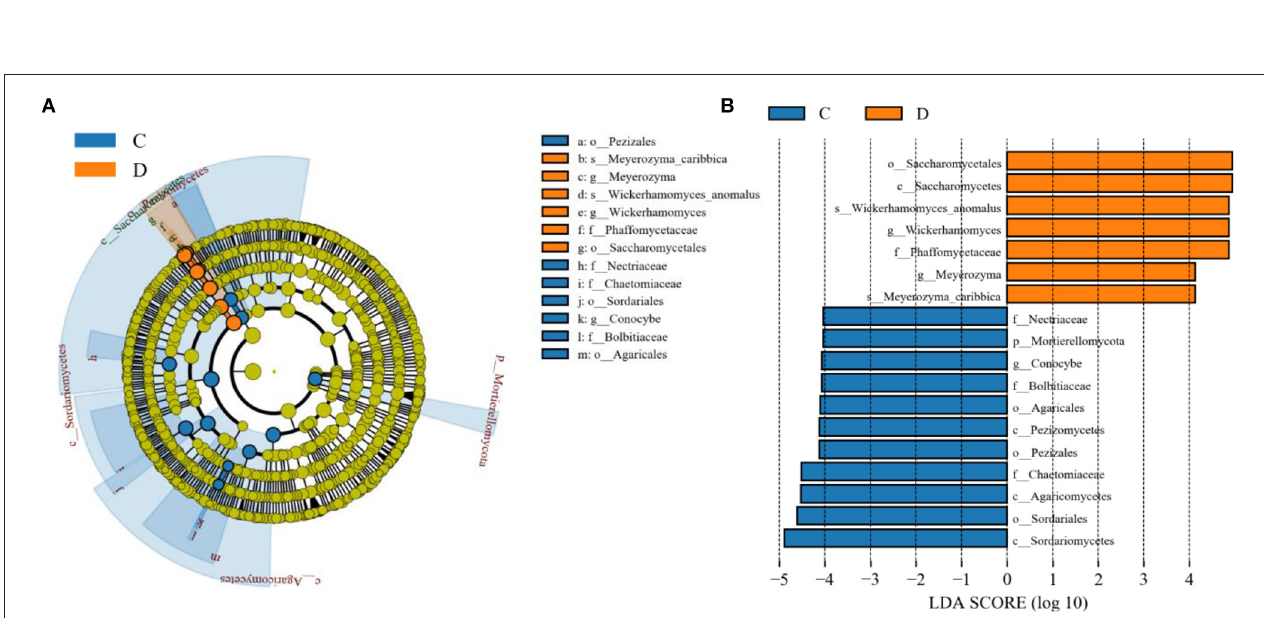
Frontiers in Veterinary Science |